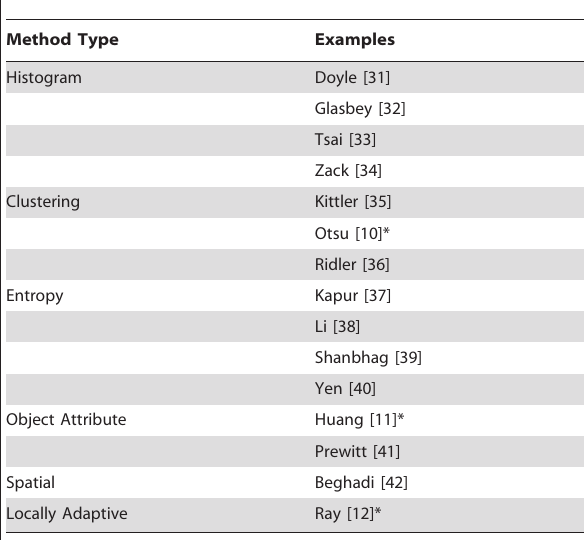
Table 1. Image Thresholding Methods